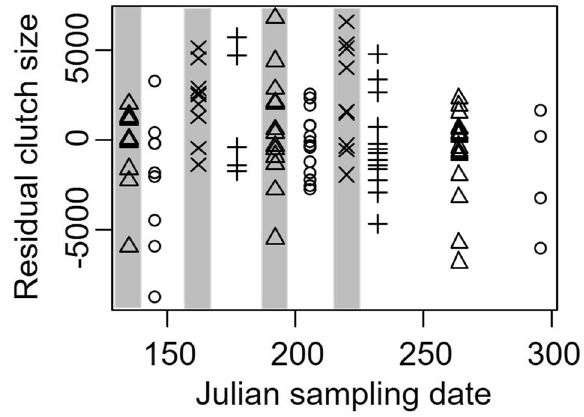
Figure 4. Residual number of eggs per clutch in Aratus pisonii (after accounting for body size) as a function of Julian sampling date. Symbols indicate sampling site, where circles are Round Island, triangles are Oslo, plus sign is North Causeway, and the multiplication sign is Pepper park. Gray shaded sampling dates indicate periods of new moon, while white indicates full